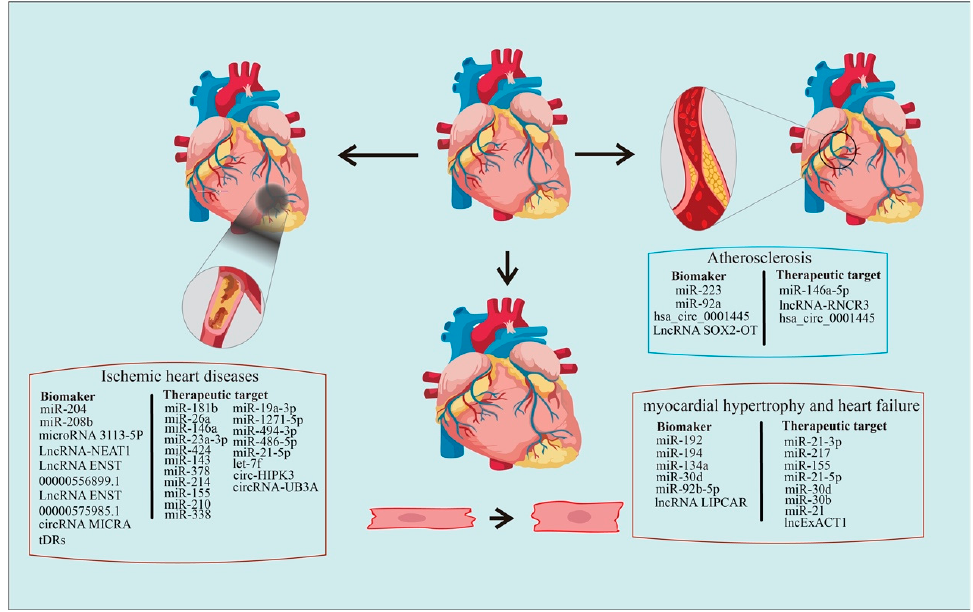
Figure 2. Extracellular non-coding RNAs as biomarkers or therapeutic targets for cardiovascular diseases. The summary of Ex-ncRNAs being identified as potential biomarkers or therapeutical targets for cardiovascular diseases.